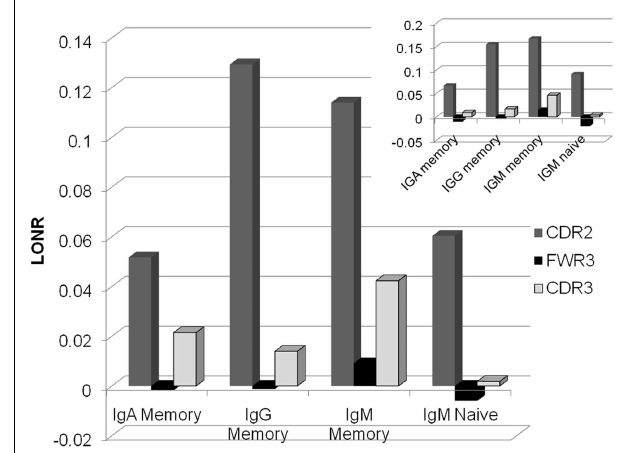
FIGURE 2 |Average LONR score per region and per isotype for all lineage trees (main figure) and for trees with a significant difference ( t -test, p < 0.01; inset) .The main positive selection occurs in CDR2, followed by CDR3. FWR3 has a limited if any negative selection. Selection occurs mainly in the memory isotype, but some systematic selection is already observed in the IgM naïve